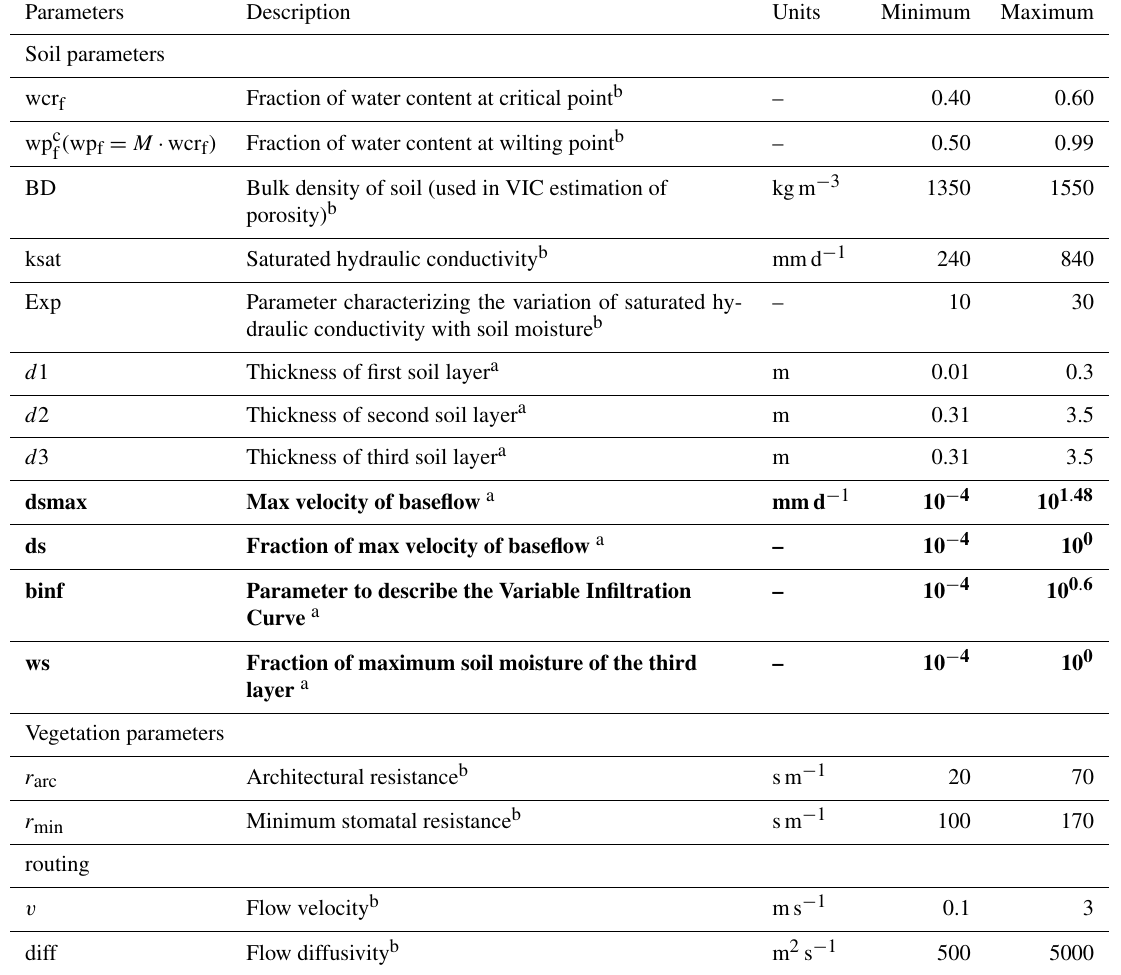
Table 1. VIC and routing model parameters tested for sensitivity analysis and feasible ranges.